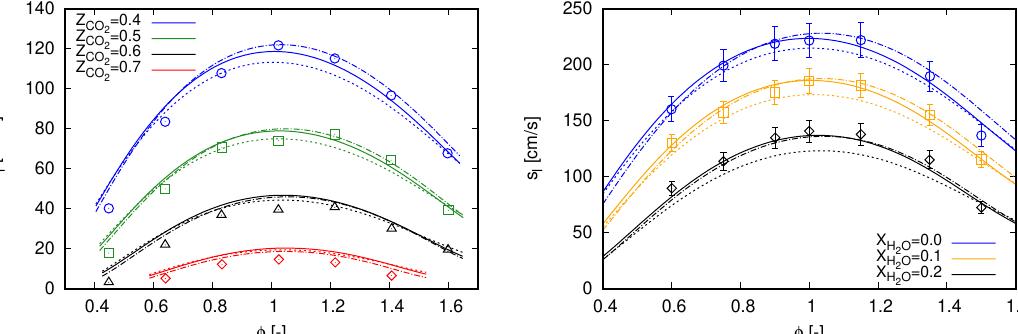
Figure 2. Laminar flame speed computed with different mechanisms using freely propagating flame reactors. Marks, experimental data; continuous lines, GRI 3.0; dashed lines, DTU; dash-dot lines, CRECK C1-C3. ( left ) CO 2 dilution with experimental data extracted from [3]; and ( right ) H 2 O dilution with experimental data extracted from